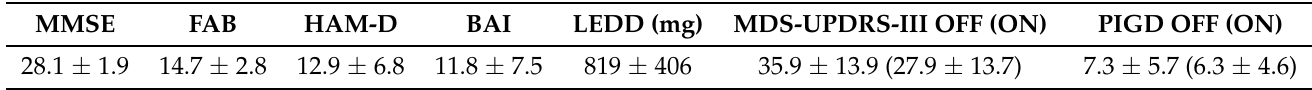
Table 2. Standardised scales and scores of patients enrolled in the present study (mean ± stan- dard deviation). MMSE: mini-mental state examination; FAB: frontal assessment battery; HAM-D: Hamilton depression rating scale; BAI: Beck anxiety inventory; LEDD: L-Dopa equivalent daily dose; MDS-UPDRS-III: Movement Disorder Society—unified Parkinson’s disease rating scale part III; OFF: not under dopaminergic therapy; ON: under dopaminergic therapy; PIGD: postural instability/gait difficulty